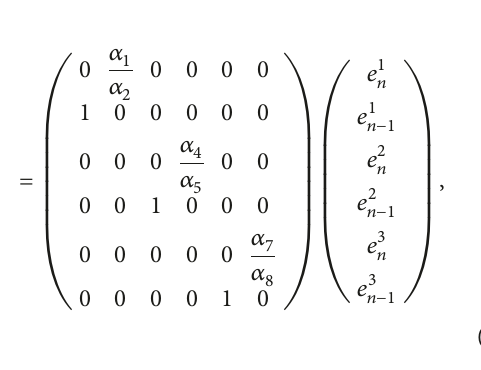
Figure 1: Phase portrait of